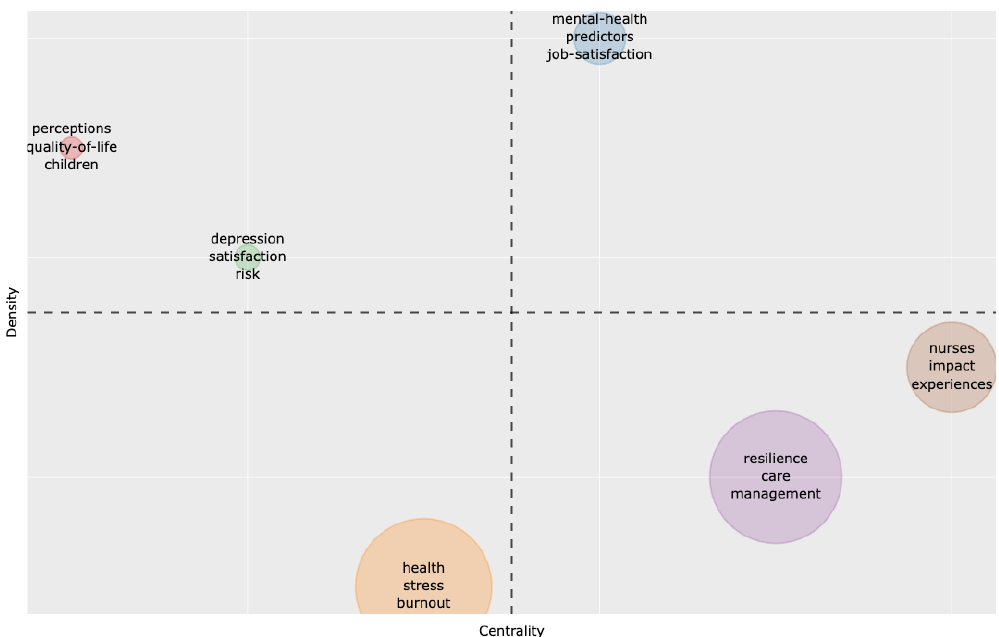
Fig. 5. Thematic map, 2005–2022 (up to 7 September). Source: developed by the